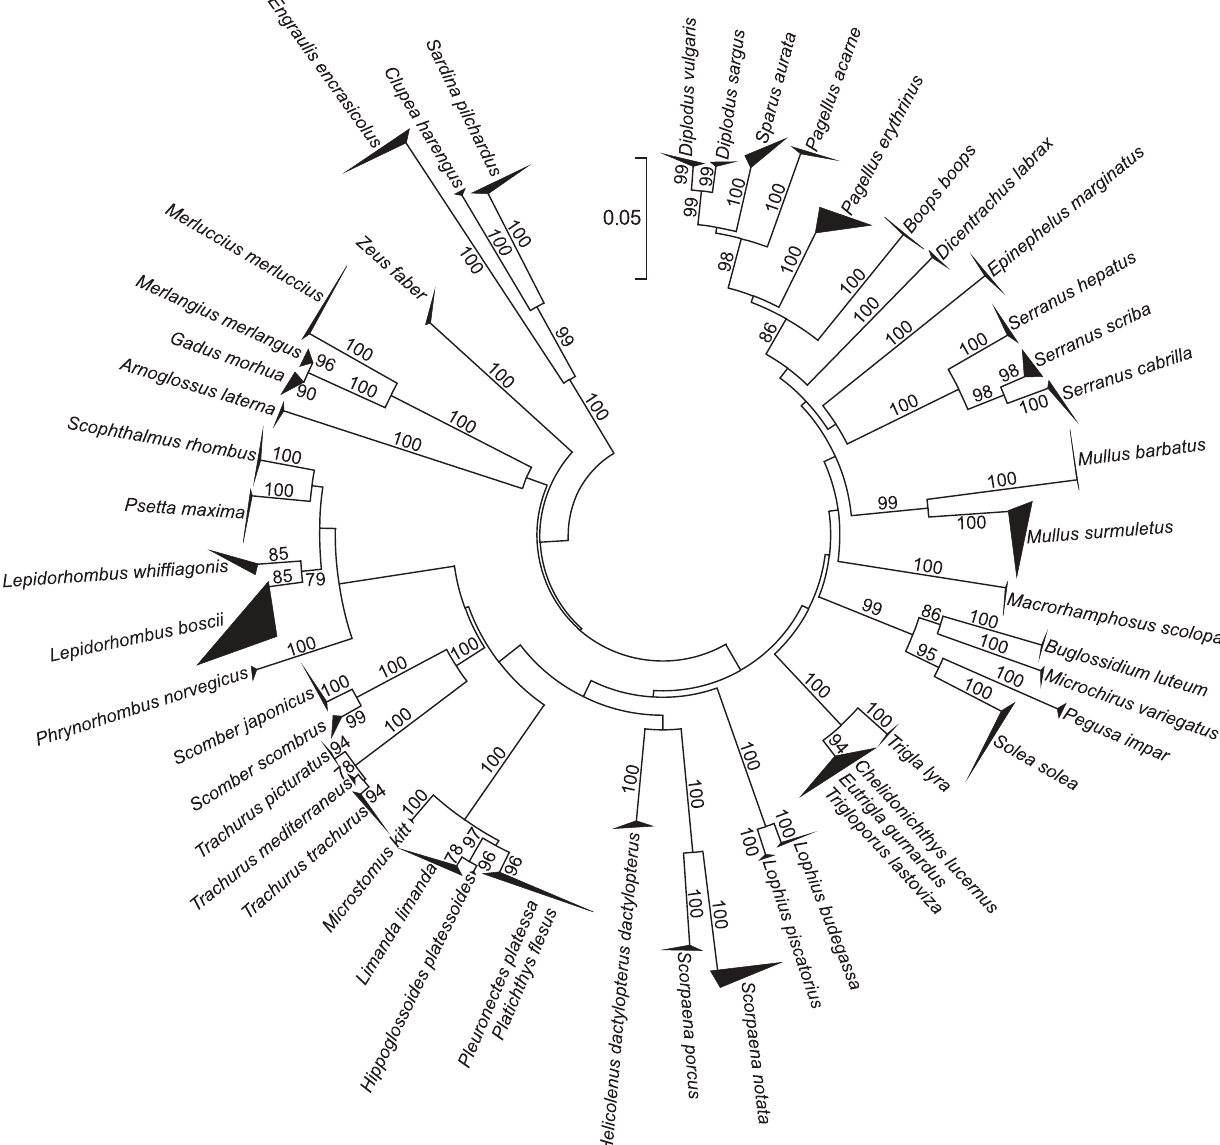
Figure 3. Phylogenetic analysis (16S). Neighbour Joining tree for partial sequences of the mitochondrial 16S rRNA gene of fishes from European seas. The number of sequences and their geographic origin for each species are given in Table 1 and Supporting Information Table S1. Bootstrap values based on 1000 replicates are indicated at branches.